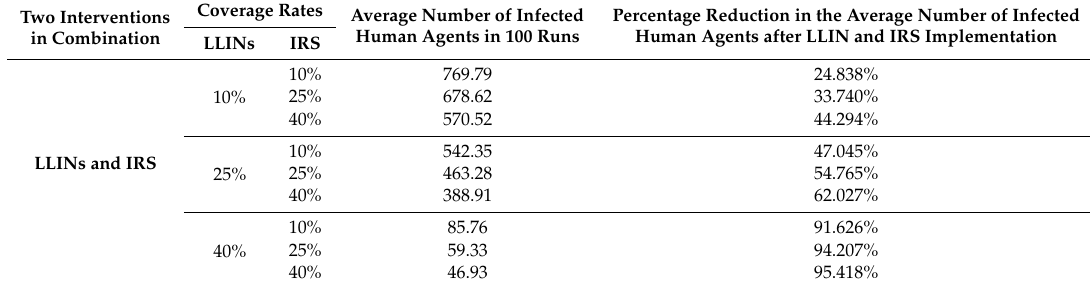
Table 5. Results of applying LLINs and IRS in